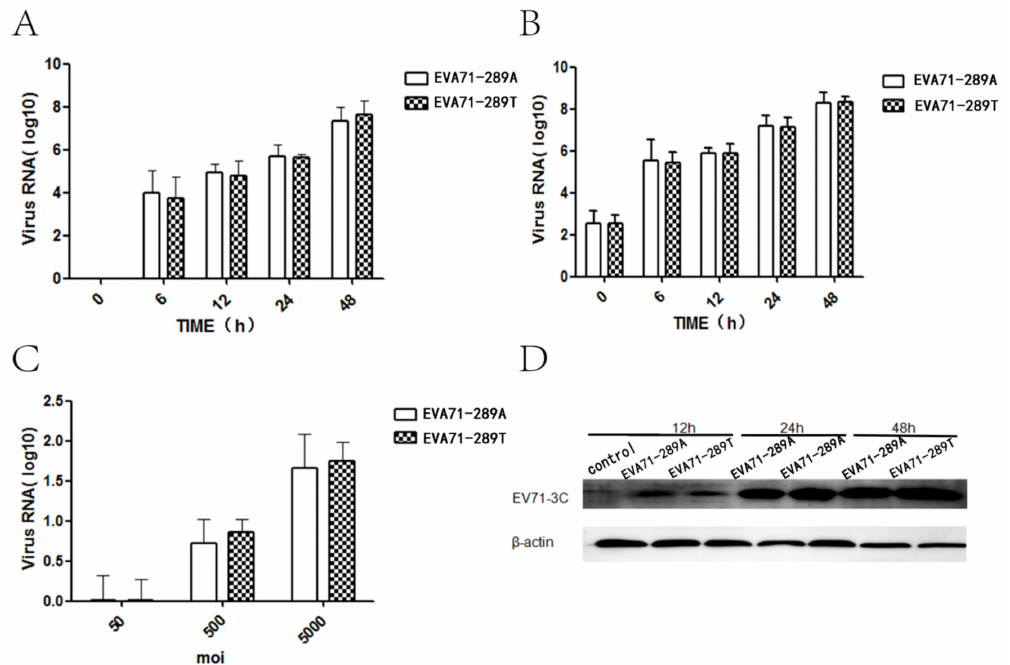
Figure 1. Viral Kinetics of EV-A71-289A and EV-A71-289T in Rhabdomyosarcoma (RD) cells. RD cells were infected with EV-A71-289A and EV-A71-289T. At each time point after infection, intracellular ( A ) and extracellular ( B ) viral RNA expression levels were detected via quantitative RT-qPCR analysis. The capacity of attachment of EV-A71-289A and EV-A71-289T to RD cells was detected via RT-qPCR analysis after infection at 4 ◦ C for 1 h at various values of multiplicity of infection ( C ). Viral protein levels were detected via western blotting after RD cells were infected with EV-A71-289A and EV-A71-289T at each timepoint at a MOI of 5 ( D